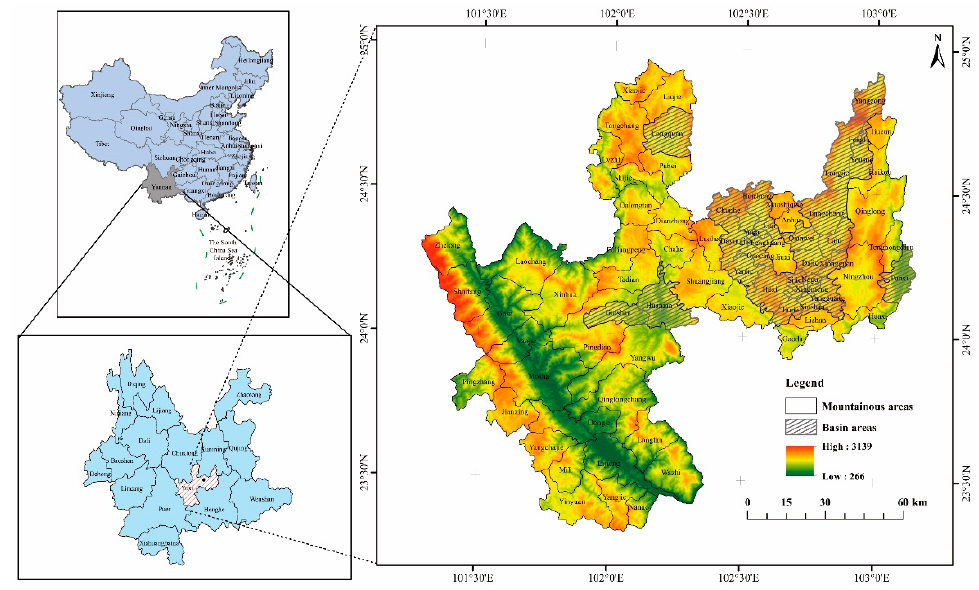
Figure 1. Location and elevation of the study area.